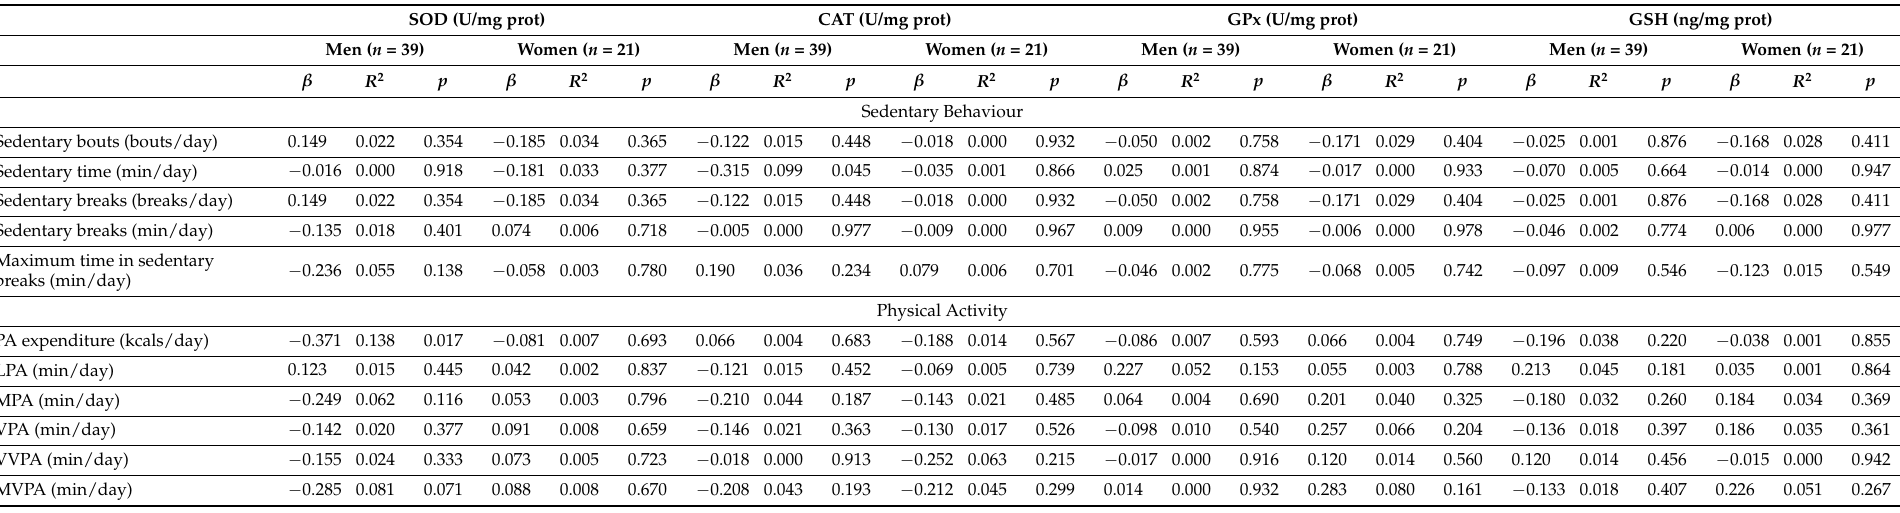
Table 2. Associations of physical activity and sedentary behaviour with enzymatic antioxidant markers.